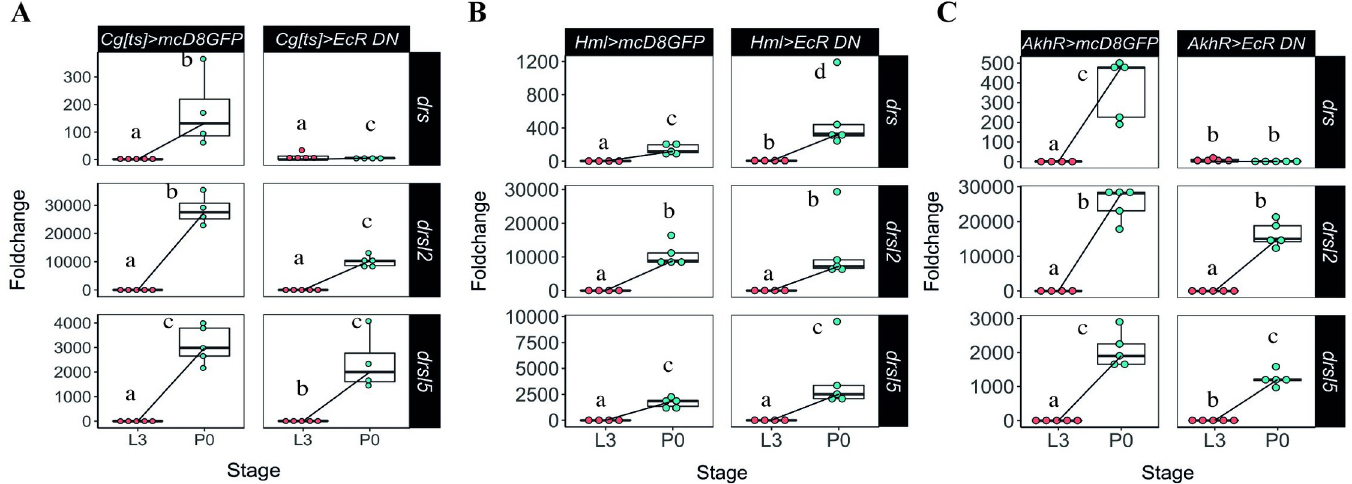
Fig 3. Expression of drs at pupariation is developmentally regulated by ecdysone in the fat body. (A) Foldchange increase in drs expression (but not of drsl2 or drsl5 ) at pupariation was eliminated when ecdysone sensitivity is decreased specifically in the fat body and haemocytes simultaneously ( lsmeans(pairwise~Stage|Cg[ts] > mcD8GFP) < 0 . 0001 , lsmeans(pairwise~Stage|Cg[ts] > EcRDN) = 0 . 0017 , lsmeans(pairwise~Genotype|P0) < 0 . 0001) ) (See also S4 Table). (B) Reduced ecdysone sensitivity in the haemocytes does not affect the expression of the AMPs under study ( lsmeans(pairwise~Stage|Hml > mcD8GFP) < 0 . 0001 , lsmeans(pairwise~Stage|Hml > EcR DN) < 0 . 0001 ) (See also S5 Table). (C) Reduced ecdysone signalling in the fat body resulted in decreased drs expression at pupariation (lsmeans(pairwise~Stage|AkhR > mcD8GFP < 0.0001, lsmeans(pairwise~Stage|AkhR > EcRDN) = 0.6709), without affecting the expression of drsl2 and drsl5 (lsmeans (pairwise~Stage| AkhR > mcD8GFP) < 0.0001, lsmeans(pairwise~Stage|AkhR > EcRDN) < 0.0001), for both genes) (See also S6 Table). L3 refers to larvae 24 hours after L3 moult and P0 are white pre-pupae (motionless white pre-pupae with evaginated anterior spiracles). Foldchange was determined using the ΔΔ CT method. Different letters represent statistically significant differences in